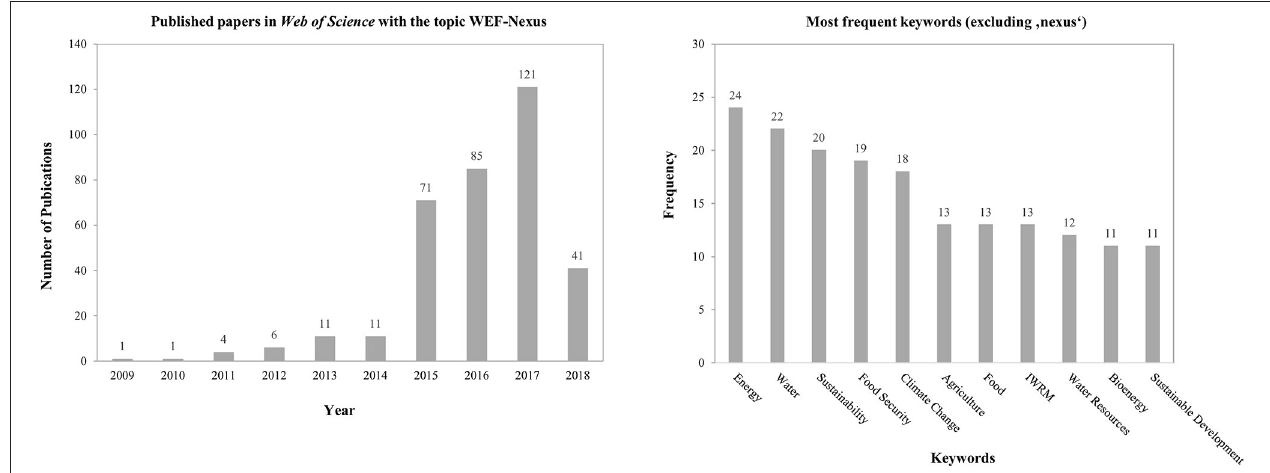
FIGURE 2 | Number of publications over time and article keywords with a count higher than or equal to 10 (last accessed 17.04.2018).